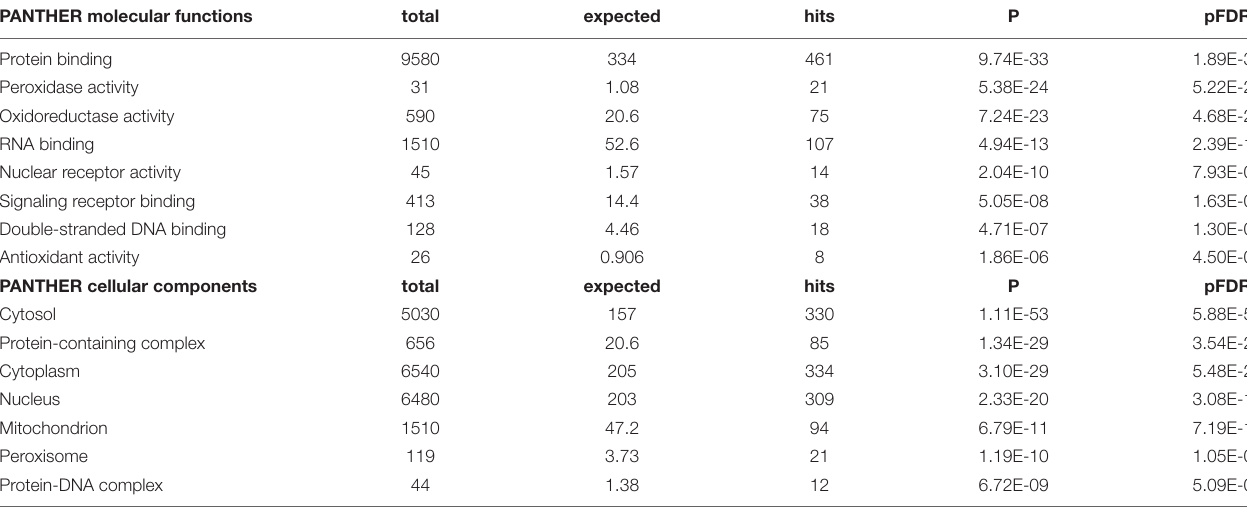
TABLE 2 | PANTHER molecular function and components terms associated with chronic fatigue spectrum disorders. PANTHER molecular functions total expected Protein binding